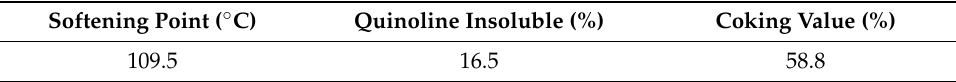
Table 2. Properties of the coal tar pitch used as binder phase in anode samples [26,28]. Softening Point ( ◦